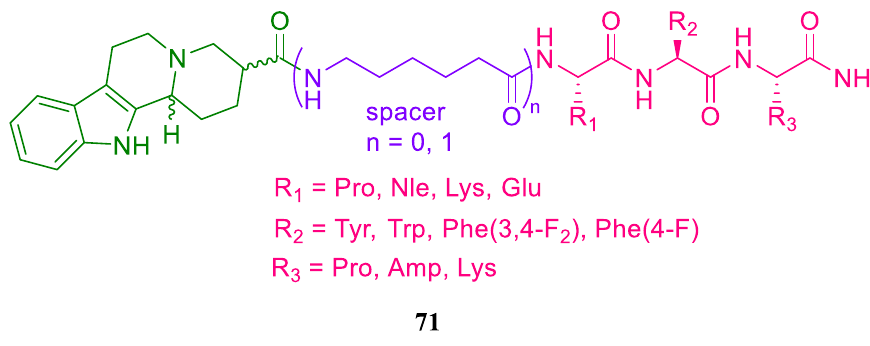
Figure 59. Peptides conjugated to indoloquinolizidine.